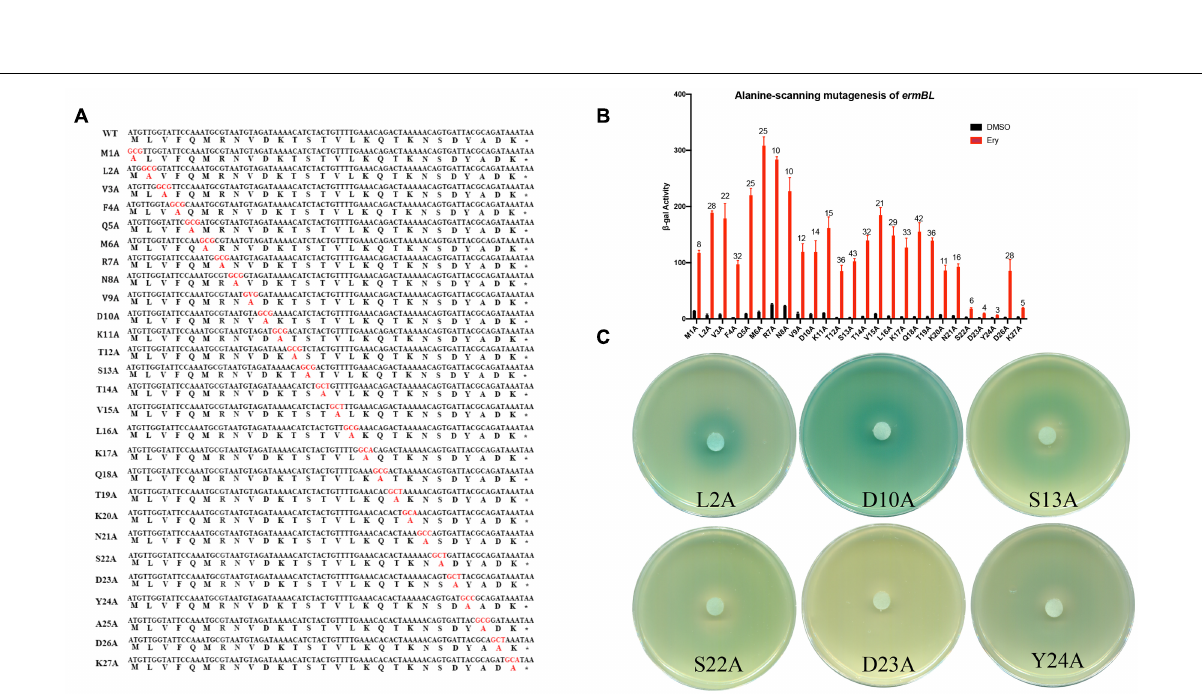
Frontiers in Microbiology |